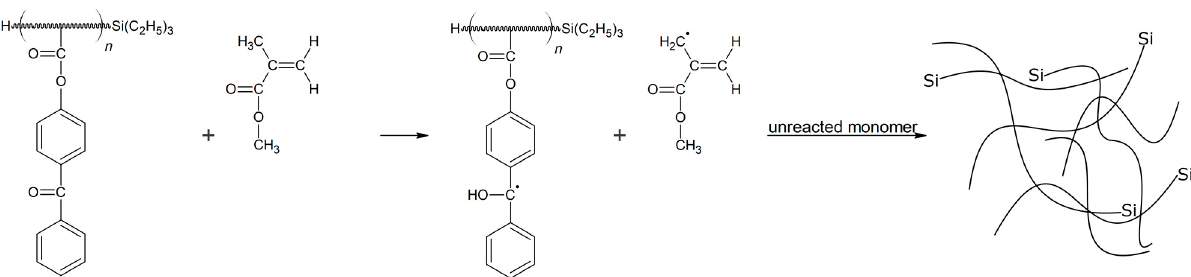
Figure 2. Probable course of photocrosslinking process for Si telomer-based PSAs with pendant benzophenone groups.